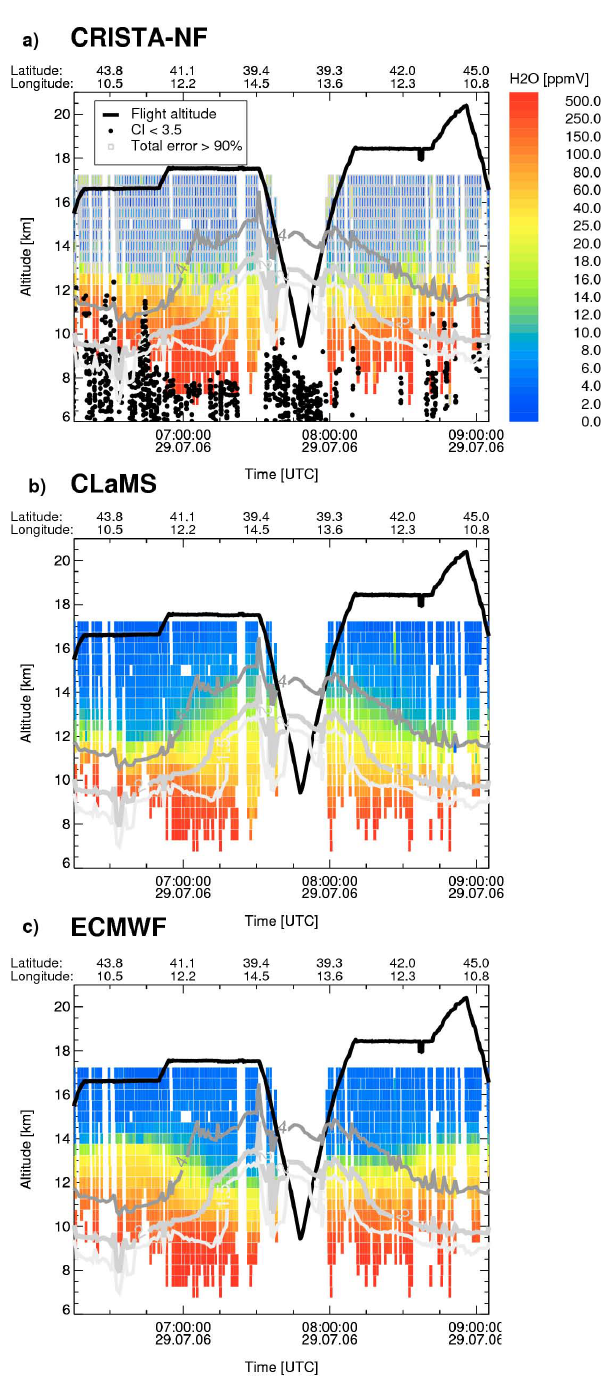
Fig. 3. H 2 O from CRISTA-NF, CLaMS, and ECMWF analysis data. Colour scale shows the H 2 O volume mixing ratio, grey lines show the ECMWF potential vorticity at 1.5, 2 and 4PVU, black line the flight track, black dots spectra with optical dense conditions, grey diamonds retrieval results with a total error larger than 90% (with CRISTA-NF H 2 O). Note nonlinear colour